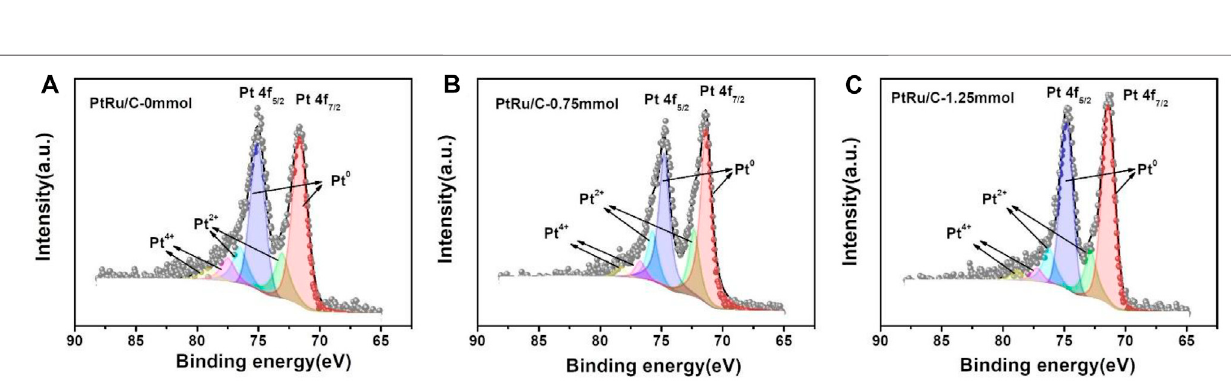
Frontiers in Chemistry |